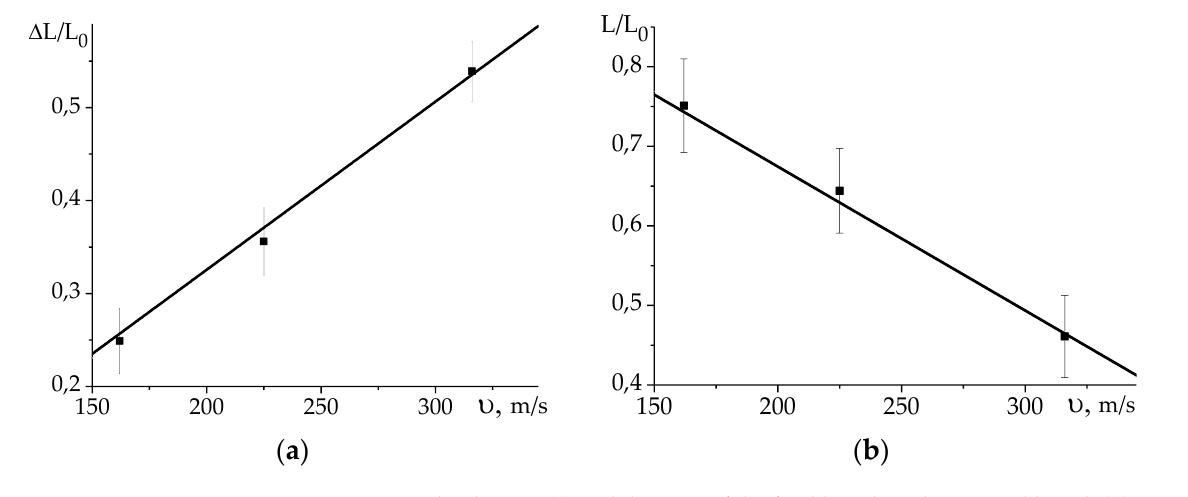
Figure 6. Longitudinal strain ( a ) and the ratio of the final length to the original length ( b ) versus the impact velocity of the specimen.